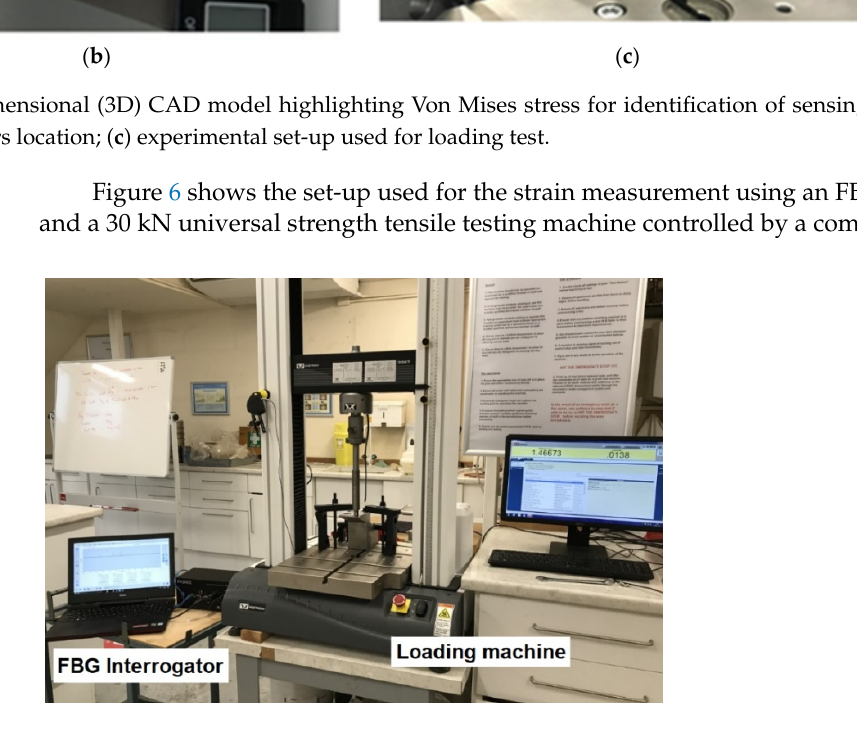
Figure 6. The set-up used for the experimental strain measurement tests.